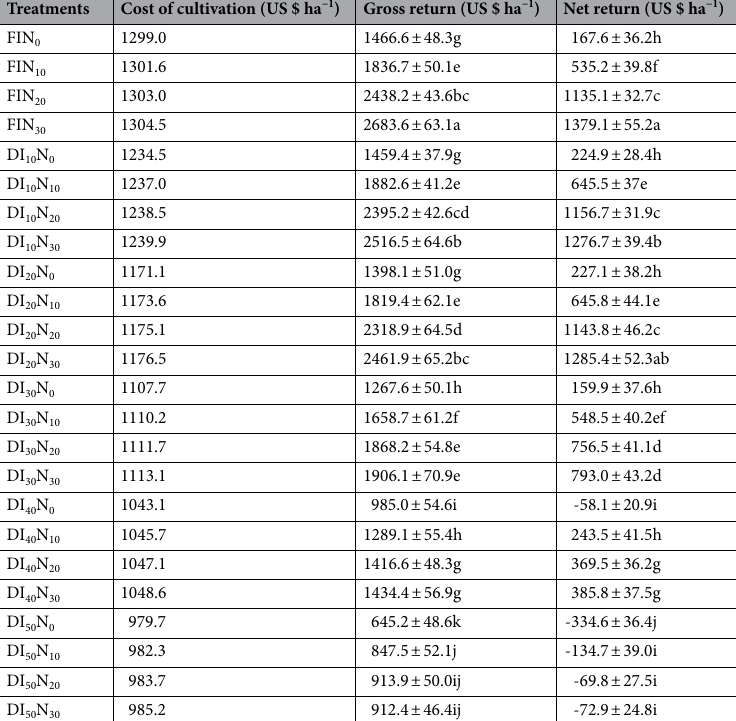
Table 3. Cost and economic benefits of peanut under different irrigation and N application rates [Values are mean ± standard error, n = 9 (3 × 3; 3 growing seasons and 3 replications per treatment)]. Values within a column for each variable followed by different letter/s are significantly different at P < 0.05 level. The details of treatments are given in Table 1.